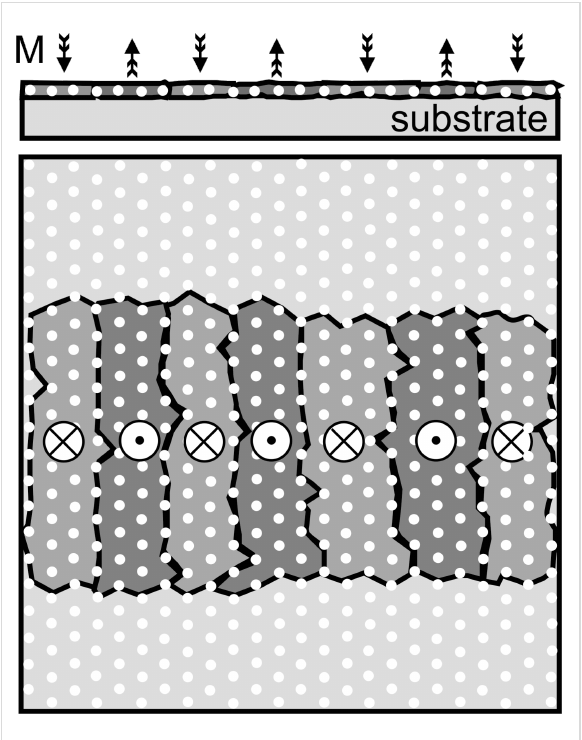
Figure 1: Principle of percolated perpendicular media. The exchange- coupled film is interspersed by nonmagnetic nanostructures (white dots) allowing domain-wall (black lines)